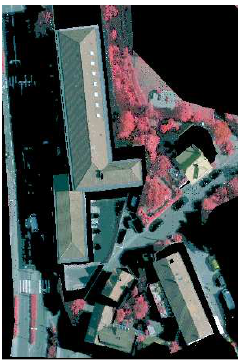
Figure 4. The figure shows the result from developing a 3D model for area 1.